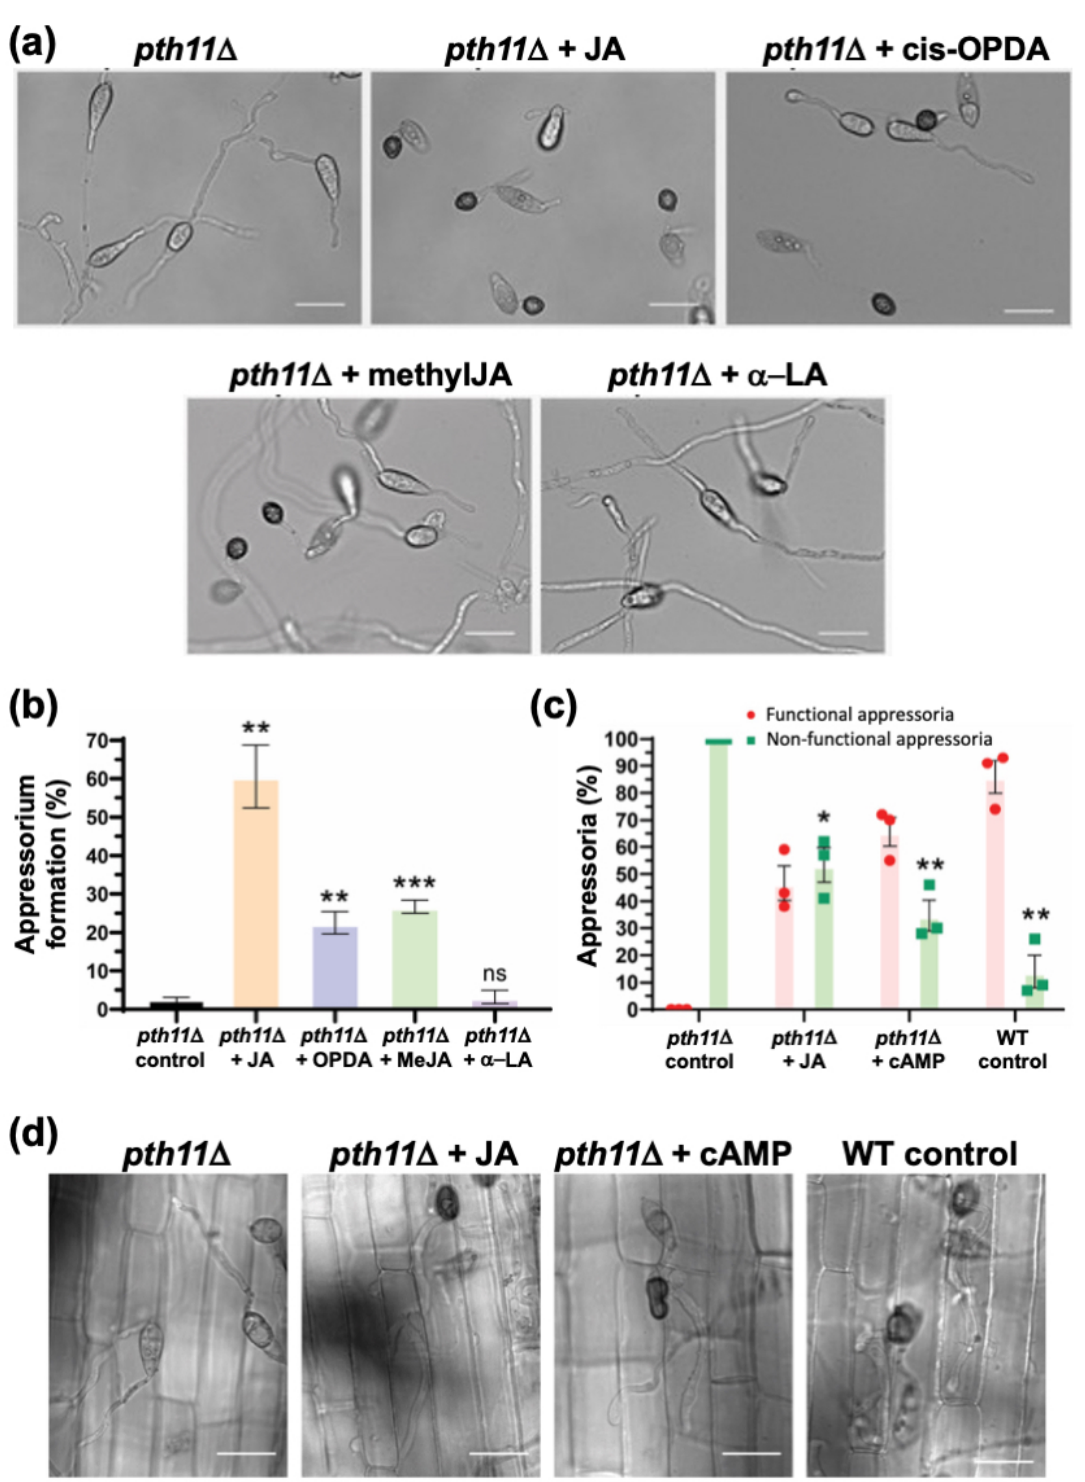
Figure 6. Jasmonate, cis-OPDA and MeJA, but not α -LA, restore appressorium formation and pathogenicity in the pth11 ∆ mutant. ( a ) Exogenous jasmonic acid restores appressorium formation in the pth11 ∆ mutant. Conidia from pth11 ∆ strain were inoculated on the inductive surface for 24 h in the absence or presence of the indicated oxylipin metabolite or a-linolenic acid. Treatment with JA, cis-OPDA or MeJA, but not a-LA significantly restored appressorium formation in pth11 ∆ . ( b )